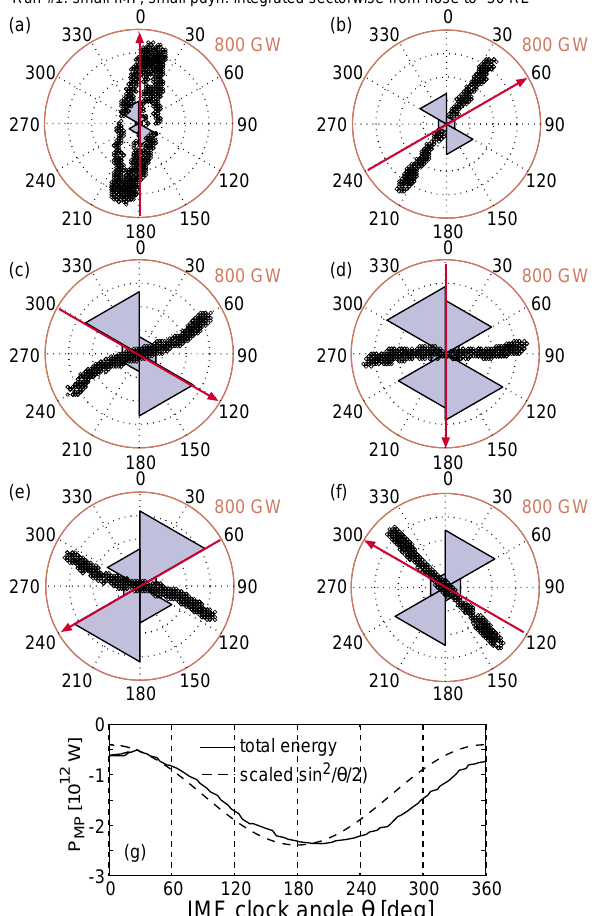
Fig. 2. (a–f) Instantaneous distributions of azimuthal magne- topause energy transfer at angles indicated by dashed vertical lines in panel (g), which presents the time evolution of total transferred energy for Run #1. Blue color indicates inward (towards magne- topause) energy to sectors shown outside the outer circle. The sec- tors scale from 0GW at the centre to 800GW at the outer circle. The IMF clock angle direction is indicated by a red arrow, while black circles show the locations where the “four-field junction” con- dition holds; i.e., where reconnection is likely to occur (note that the dayside black circles in panel (a) indicate sunward convection, not reconnection, which occurs behind the cusps as deduced from the annihilation of magnetic energy). (g) The solid line is the total transferred energy as function of clock angle (and time), while the dashed line is sin 2 (θ/ 2 ) . Although the figure is for Run #1, the other runs behave qualitatively similarly, only the amount of transferred energy in the other runs is different (see Palmroth et al., 2006).